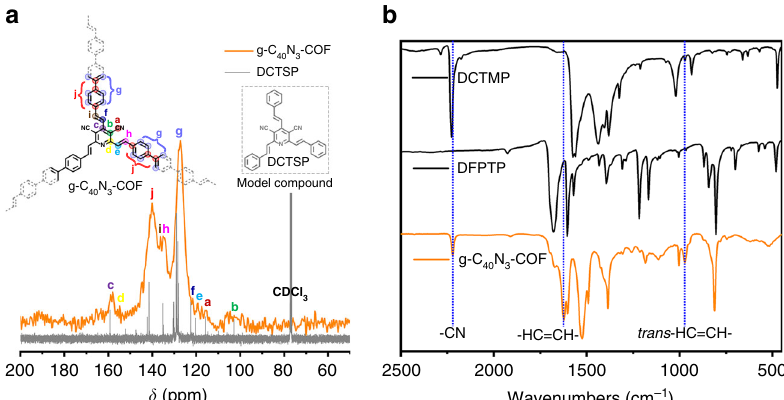
Fig. 3 Characterizations of chemical structures for g-C 40 N 3 -COF. a 13 C CP/MAS solid-state NMR spectra of g-C 40 N 3 -COF, compared with 13 C NMR spectra of DCTSP (model compound) in CDCl 3 . b FT-IR spectra of g-C 40 N 3 -COF and corresponding monomers